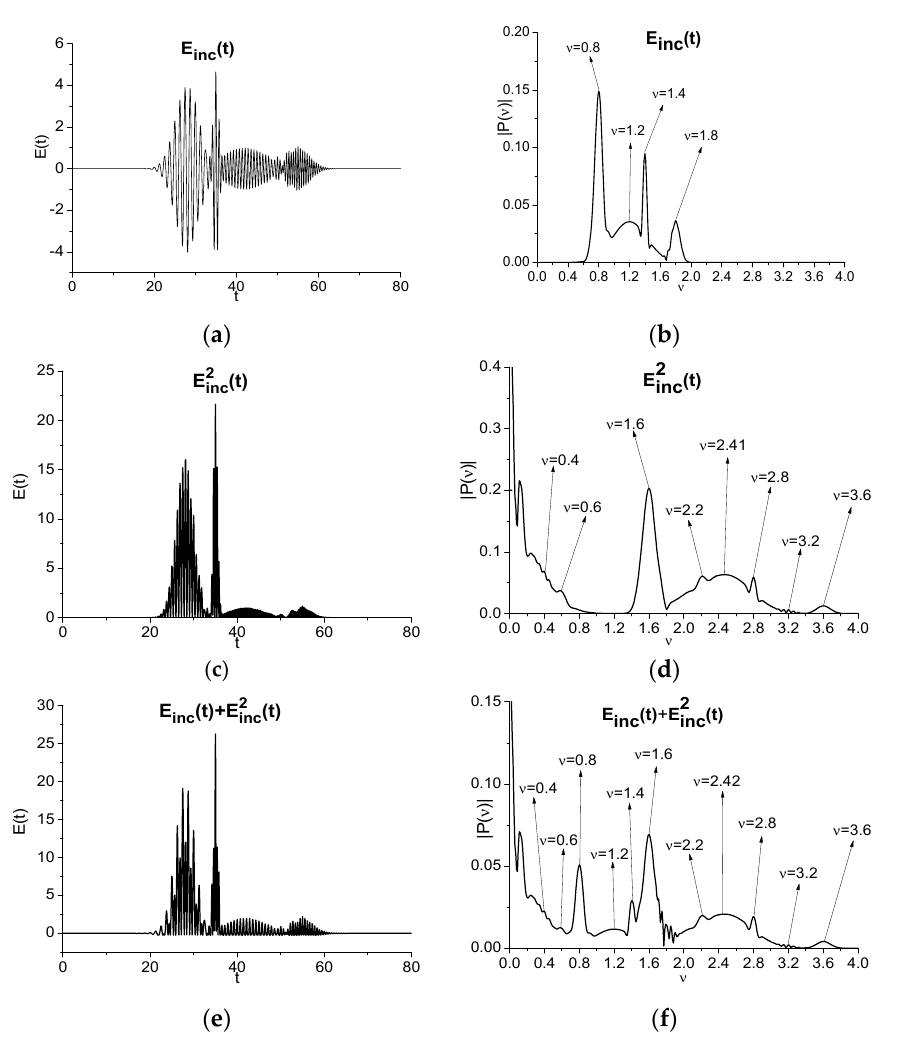
2 ( ) E t ( c ) and their Fourier spectra ( b , d ); normalized ( t ) ( c ) and their Fourier spectra ( b , d ); normalized (Equation inc inc ( 2 ) χ ( t ) ) with parameter χ ( 2 ) E 2 (2) 2 ( ) ( ) = 1.0 ( e ) and its spectrum ( f E t E t χ+ ) with parameter (2) = 1.0 ( e ) and its spectrum ( f ). inc dl dl inc dl inc dl